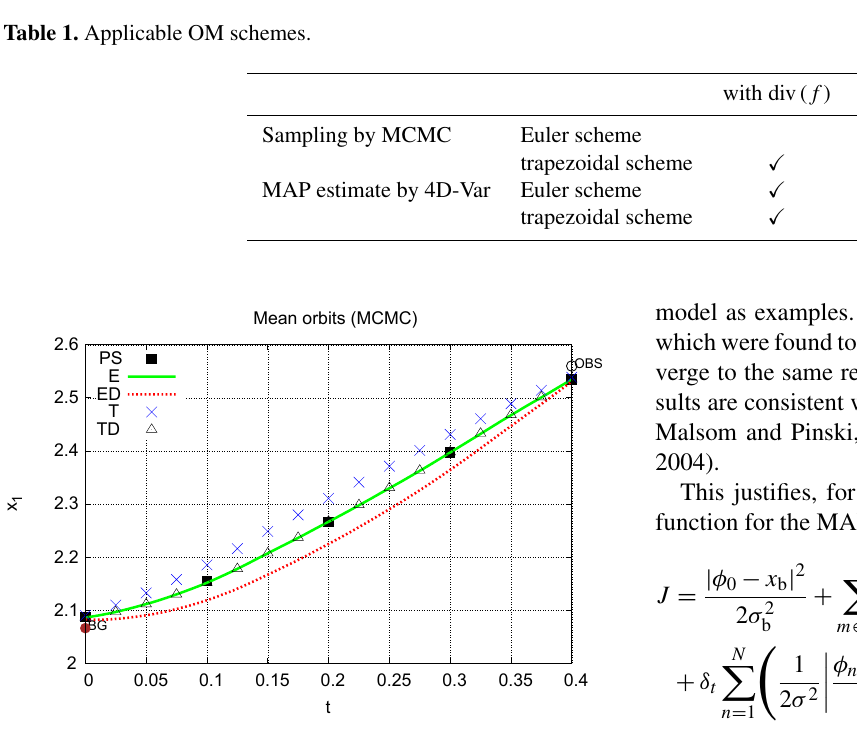
Figure 4. Expected path derived by MCMC (Rössler model).